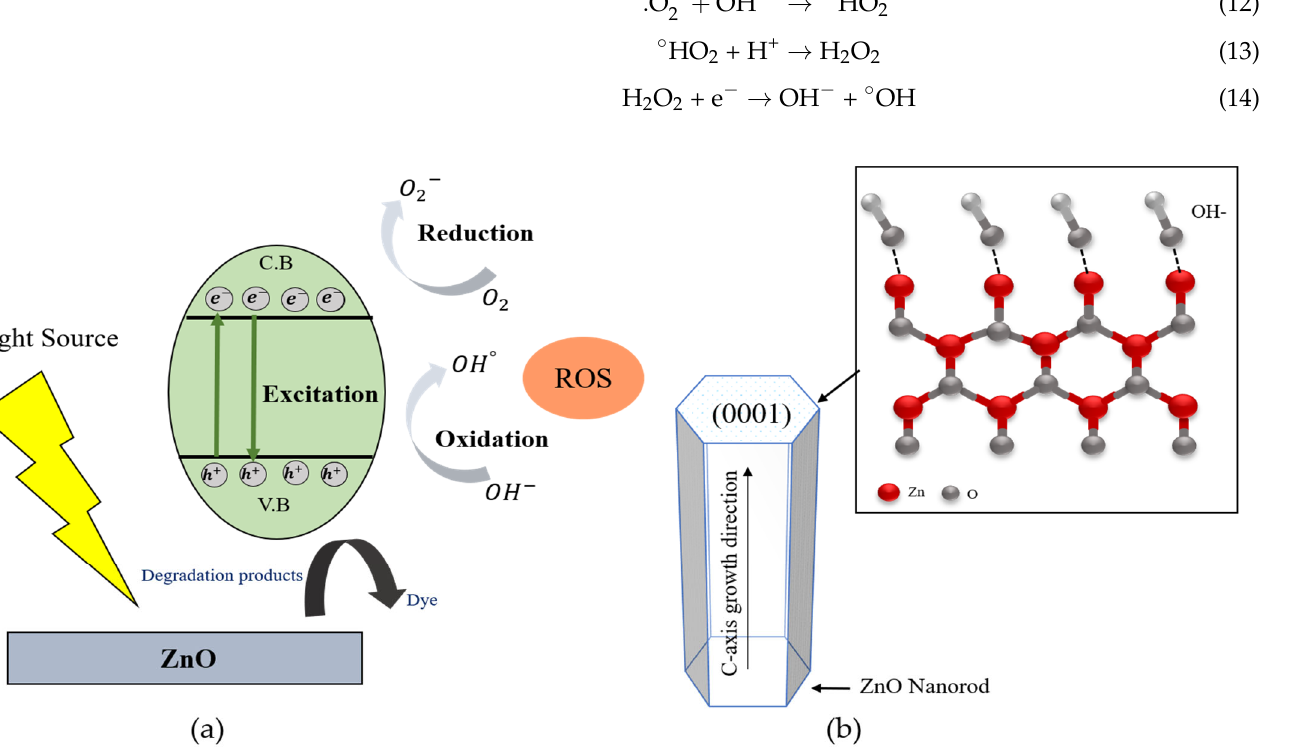
Figure 7. ( a ) Schematic diagram of photocatalytic mechanism of ZnO, and ( b ) (0001) plane of ZnO nanorod for photocatalytic efficiency. nanorod for photocatalytic